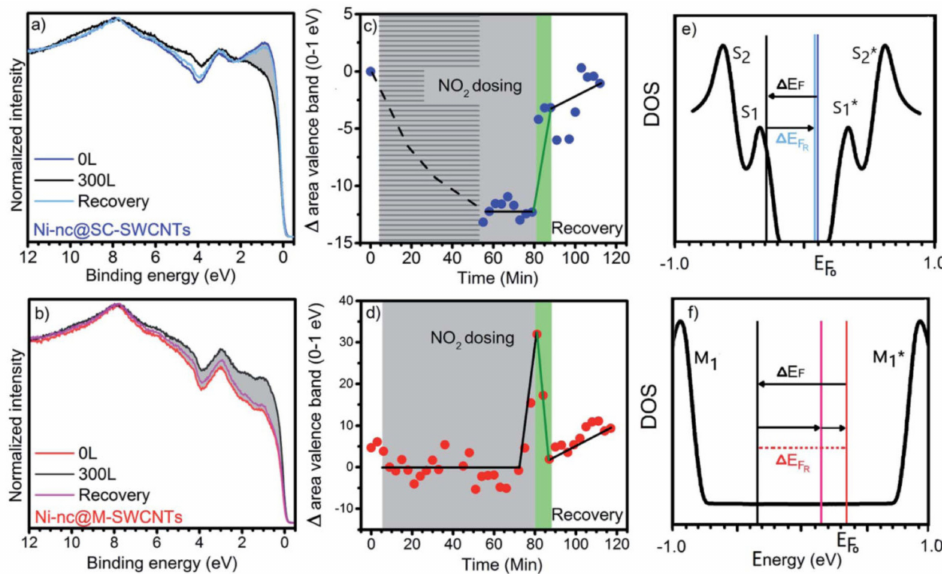
Figure 4. ( a , b ) Valence band photoemission spectra of the Ni nanocluster − filled semiconducting ( a ) and metallic ( b ) SWCNTs. In the figure, 0 L, 300 L, and recovery refer to the spectra before exposure, after exposure to 300 L of NO 2 , and after complete desorption. ( c , d ) Integrated area of the valence band spectra up to 1 eV as a function of the dosing and recovery time for the semiconducting ( c ) and metallic ( d ) Ni cluster − filled SWCNTs. ( e , f ) Sketches of the Fermi-level shifts in the density of states for Ni nanocluster-filled semiconducting ( e ) and metallic ( f ) SWCNTs. Reproduced from